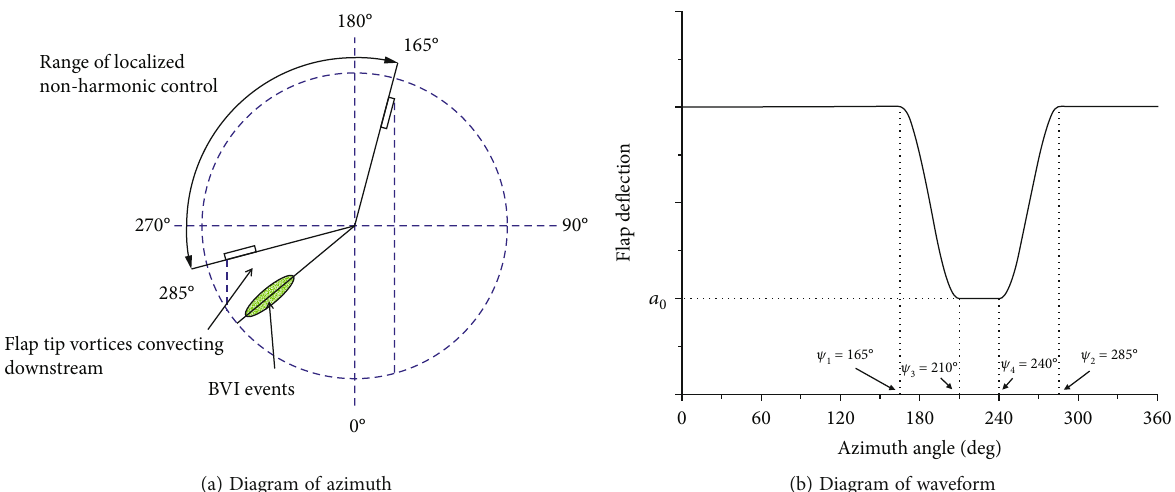
Figure 5: Schematic diagram of the azimuth and waveform of the oblique square wave input in the third quadrant of the fl ap. Table 1: Key parameters of the sample electrically controlled rotor. Parameter (unit) Value Torsional sti ff ness of the rotor root (Nm/rad)